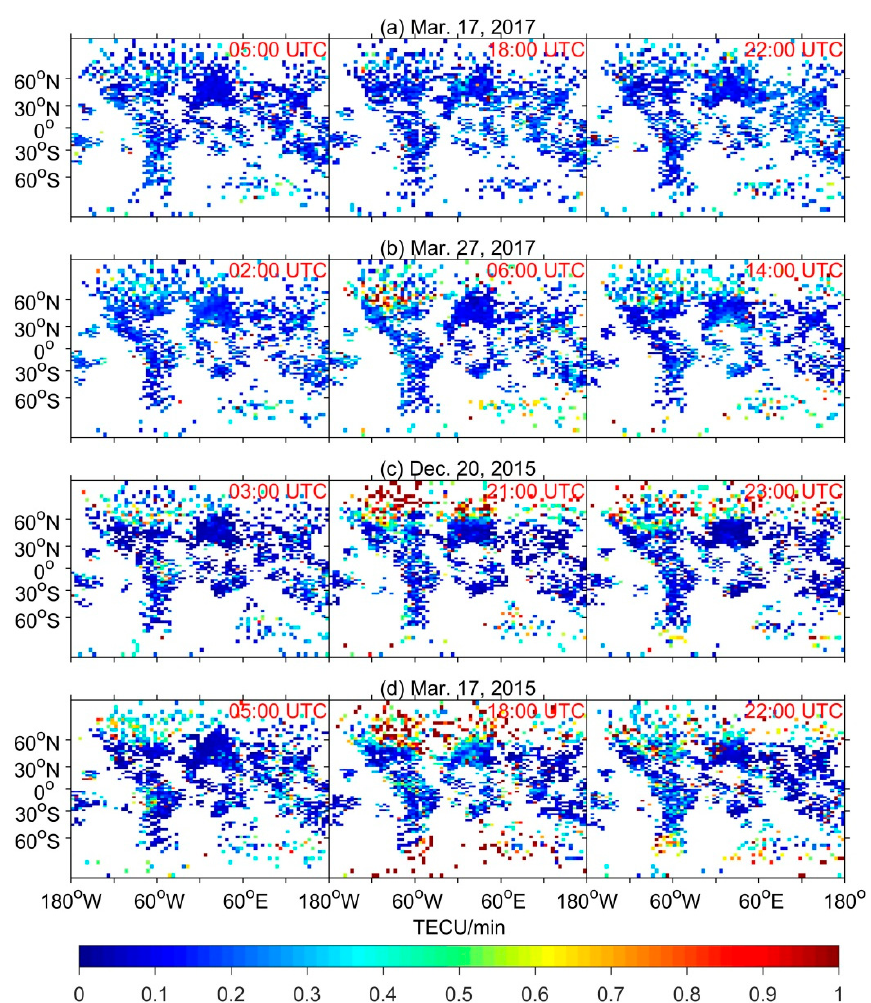
Figure 10. Global ROTI maps of the three perturbation times (i.e., the initial phase, storm development, and deep main phase) on: ( a ) 17 March 2017 as the quiet day reference; ( b ) 27 March 2017 as the moderate storm; ( c ) 20 December 2015 as the intense storm; and ( d ) 17 March 2015 as the super storm, respectively.